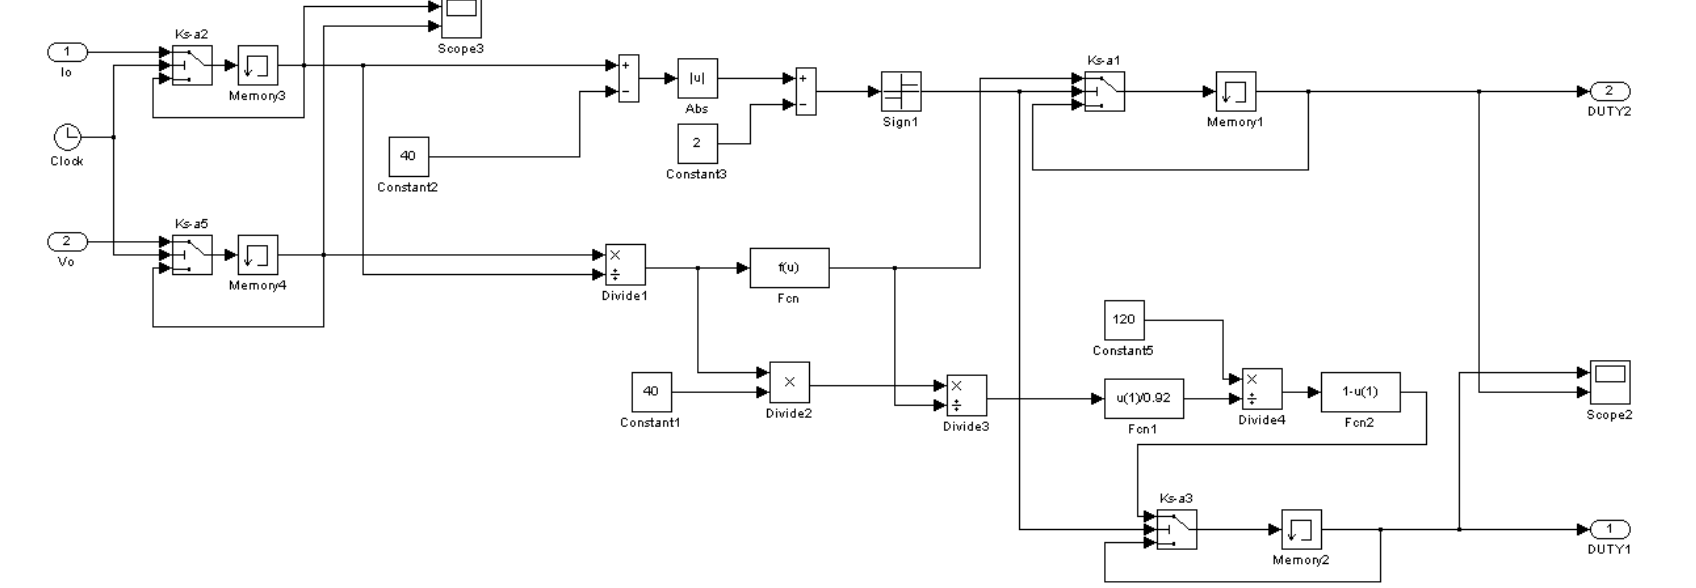
Figure 12. Controller arrangement plan of load adaptive control strategy.